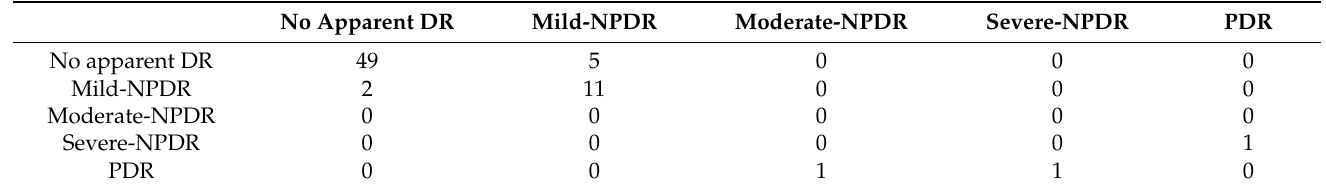
Figure 4. Scatter plots of hemorrhage count and area for eyes of patients attending a diabetes clinic and not scheduled for an eye clinic visit. The SVM model estimated stage boundaries as color-coded maps. The hemorrhage count and area tended to increase as the disease became more severe. Table 1. The confusion-matrix table for 70 eyes of patients attending a diabetes clinic and not scheduled for an eye clinic visit. The rows show numbers of true diagnoses, and the columns show values of SVM prediction. The SVM model did not misdiagnose the severe stage of moderate-or-higher NPDR as the naive or mild retinopathy NPDR stages.